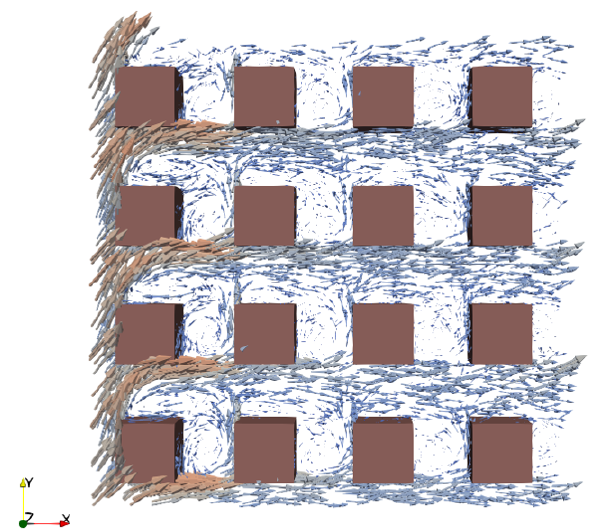
Figure 8. Flow field for a 45° inlet wind